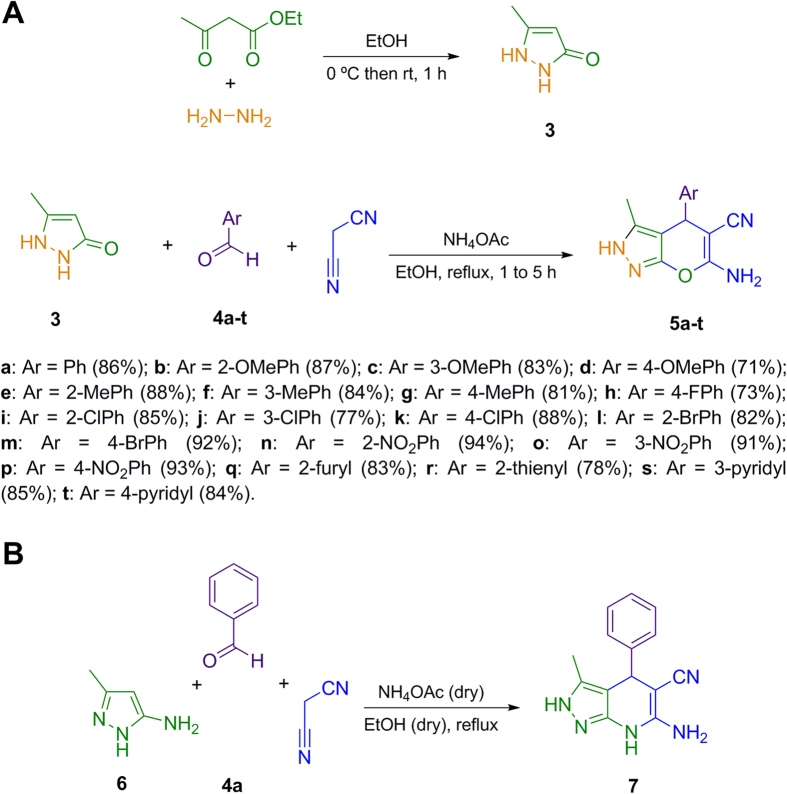
(A) Scope of the three-component synthesis of pyrano[2,3-c]pyrazoles 5a–t. (B) Three-component synthesis of 6-amino-3-methyl-4-phenyl-4,7-dihydro-2H-pyrazolo[3,4-b]pyridine-5-carbonitrile 7.